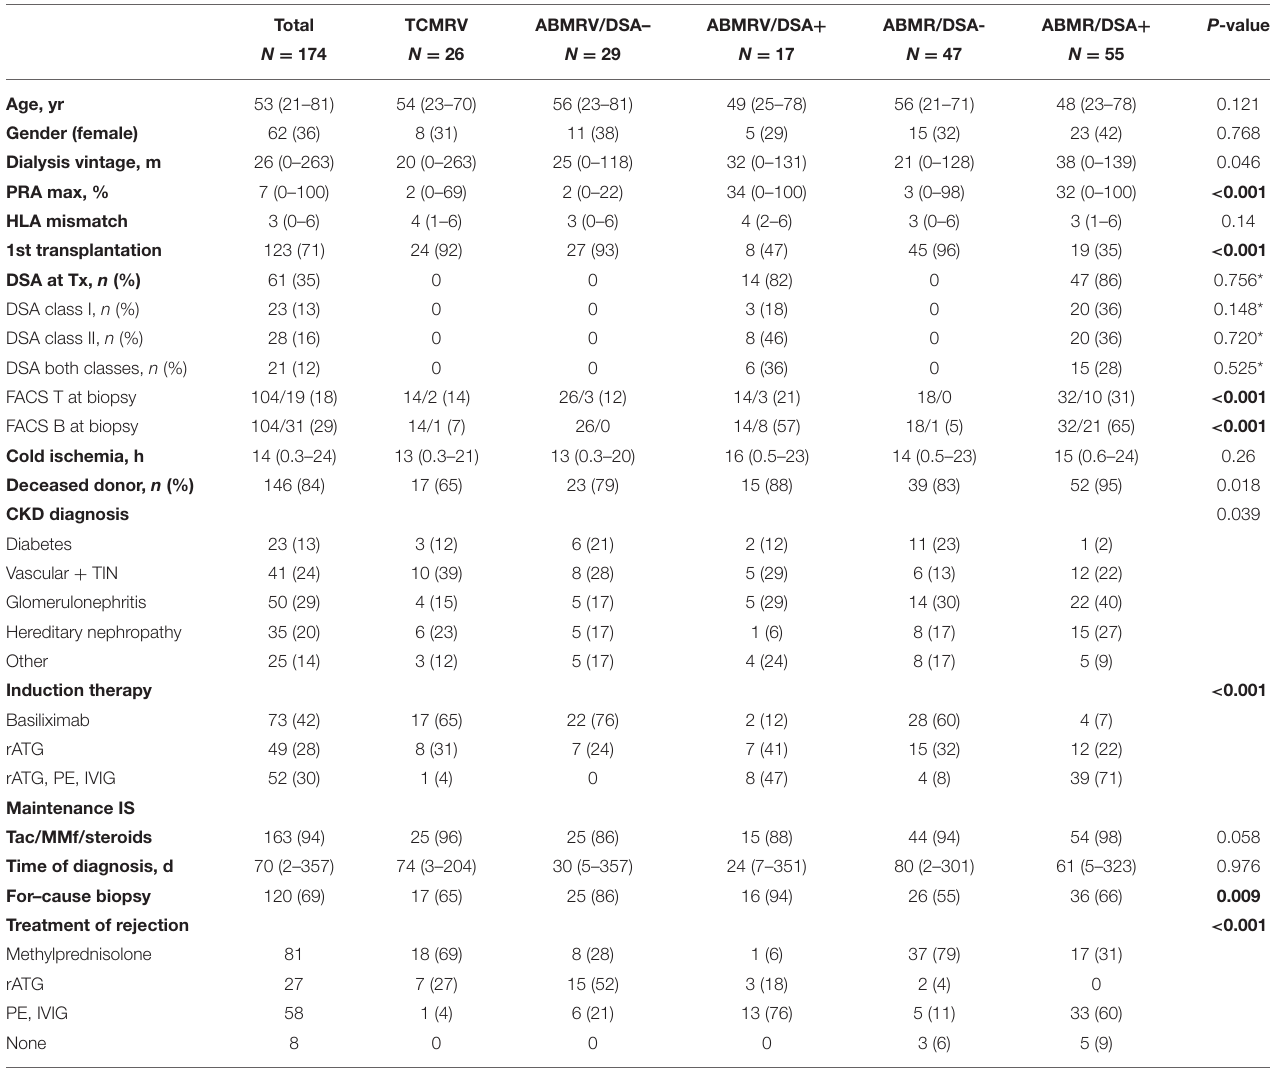
TABLE 2 | Overview of the baseline characteristics of all rejection phenotype